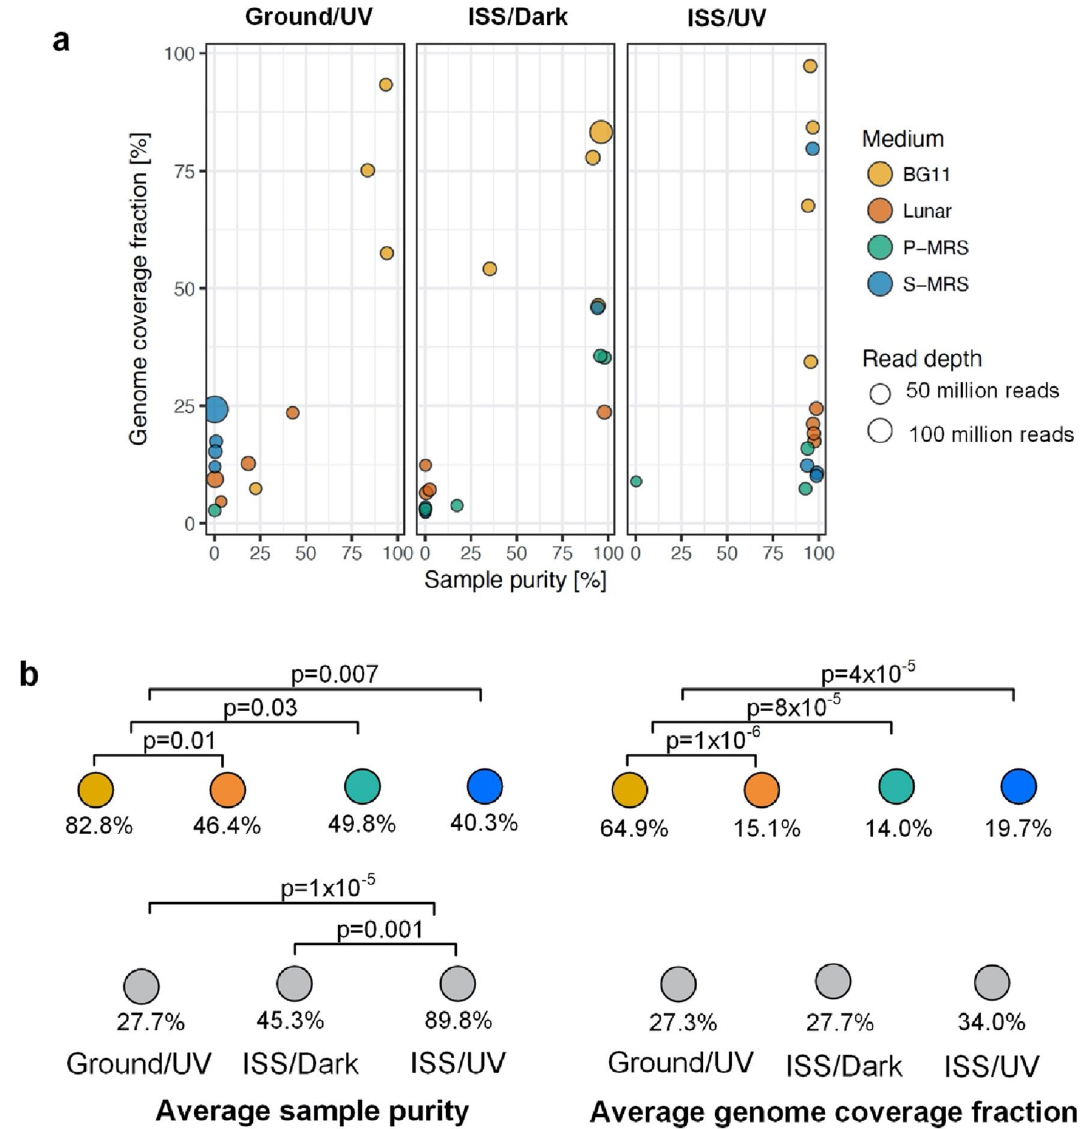
Figure 3. Sample purity and genome coverage of single cells of Nostoc sp. CCCryo 231-06 exposed to different media/substrates and exposure conditions during the BIOMEX experiment. Number of replicates per experimental conditions are described in Table S1. Different media/substrates are color-coded. ( a ) The horizontal axis represents the percentage of reads that were classified to the genus Nostoc after the metagenomic analysis of each sample and replicate. The vertical axis represents the fraction of the recovered Nostoc sp. CCCryo 231-06 that is mapped by the reads of each sample and replicate. The size of the circle represents the number of reads present in each sample and replicate. The components of the mineral substrates (lunar and Martian regoliths) are provided in Table S2. ( b ) Average sample purity and genome coverage fraction are sorted by medium and exposure condition. Samples on BG11 displayed significantly higher purity and genome coverage. Samples exposed to UV radiation on the ISS displayed significantly higher purity than those in other experimental conditions. Student’s t test was used to calculate the p-values. BG11 blue-green medium, ISS international space station, P‑MRS phyllosilicatic martian regolith, S‑MRS sulfatic martian regolith, UV ultraviolet light, Ground/UV earth with UV exposure, ISS/Dark ISS without UV exposure, ISS/UV ISS with UV